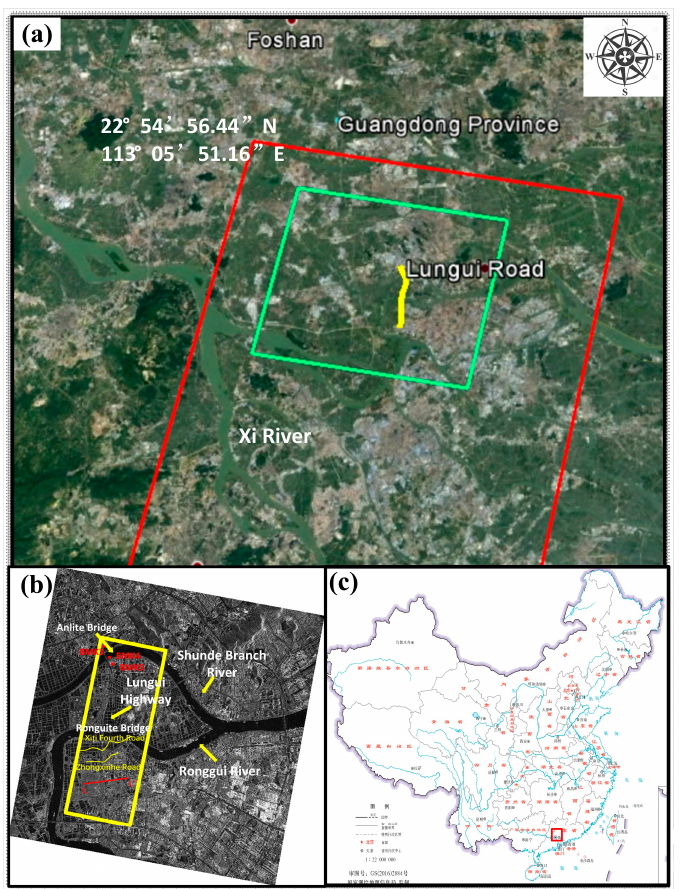
Figure 2. Study area features at different scales: ( a ) Regional scale in China; ( b ) An amplitude image of the area with the highway region of interest outlined in the yellow rectangle; ( c ) location in China. Remote Sens. 2019 , 11 , x FOR PEER REVIEW